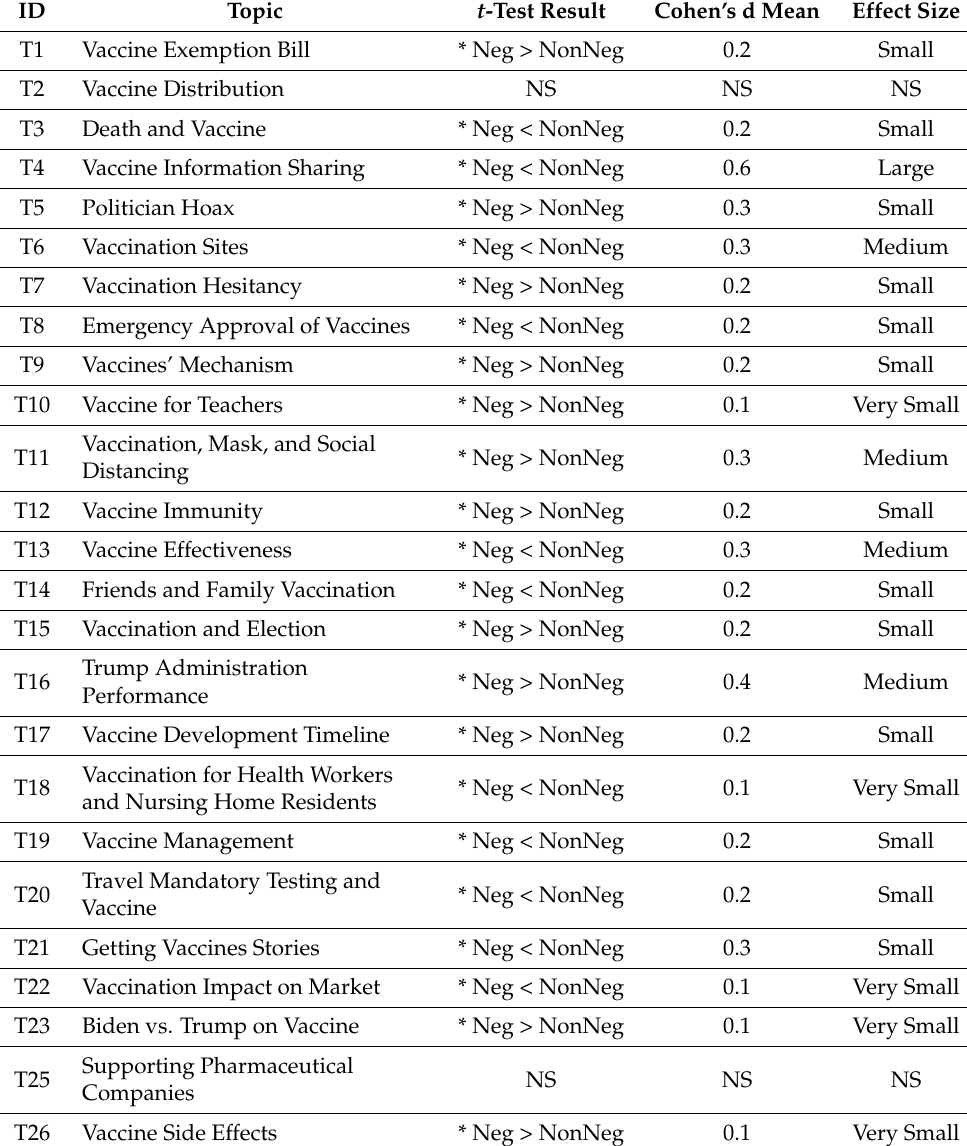
Table 2. Statistical comparison of negative and non-negative tweets regarding each topic (Neg: negative tweets; NonNeg: non-negative tweets; NS: Not Significant; *: adjusted p -value ≤ 0.001). The updated effect size column is based on the thresholds in Table